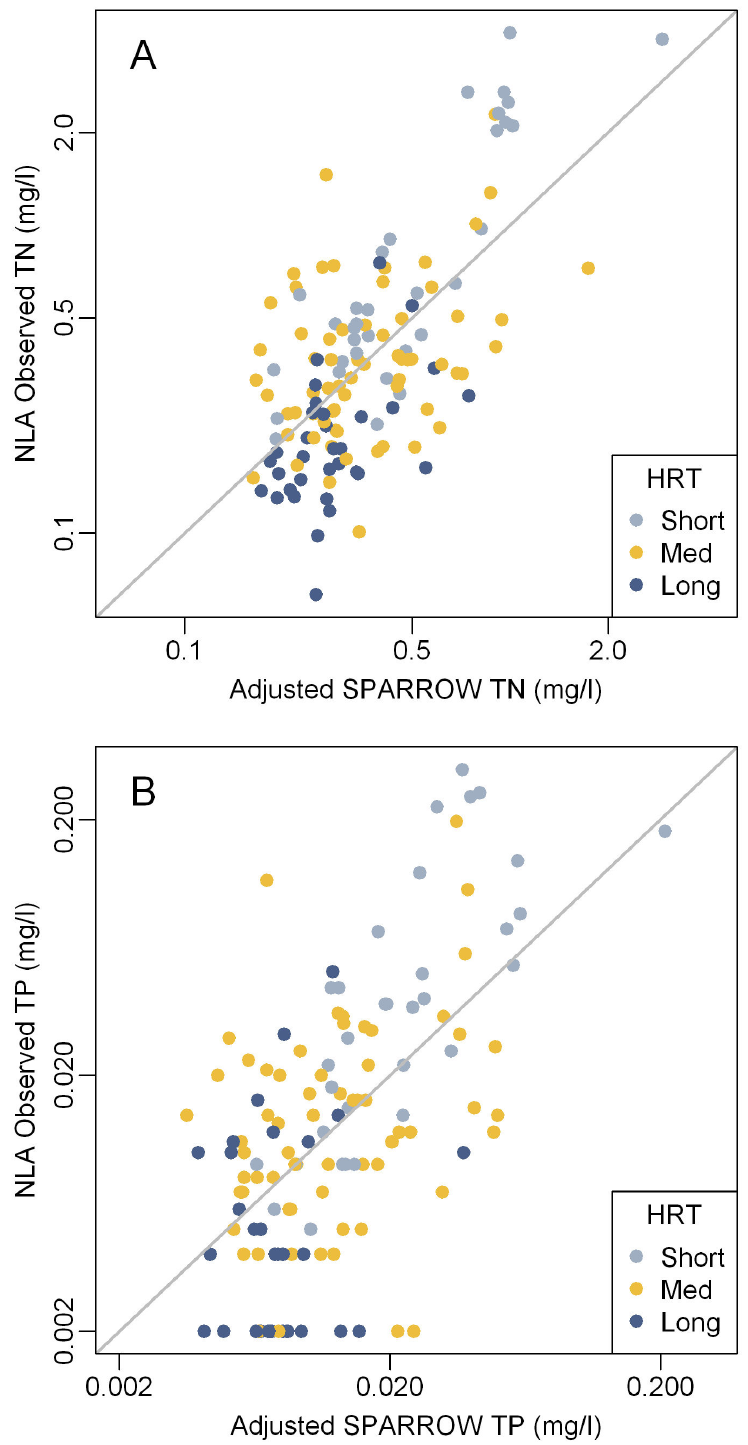
Figure 3. Adjusted (Linear Model) total nitrogen (A) and phosphorus (B) in Northeast Lakes. National Lake Assessment observed 2007 summer concentrations of (A) total nitrogen and (B) phosphorus in Northeast Lakes versus the linear model (LM) adjusted average annual SPARROW predicted concentrations. Linear regression was used to adjust SPARROW predictions to the 2007 NLA observations. Observations are color coded by hydraulic residence time (HRT: Short < 0.04 years; Medium = 0.04 to 0.4 years; Long > 0.4 years). TN = Total Nitrogen. TP = Total Phosphorus. doi: 10.1371/journal.pone.0081457.g003 PLOS ONE |